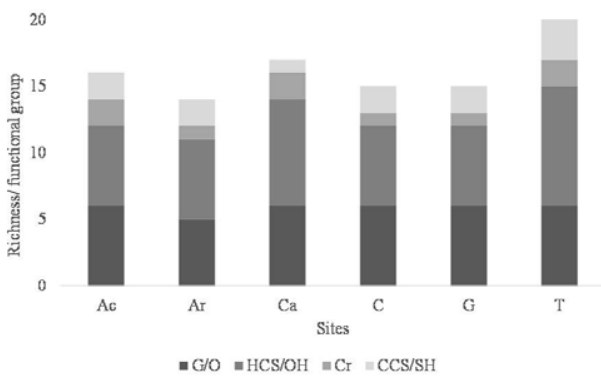
Fig 2. Richness of ants per functional group. Ac – Aciprestes; Ar – Arnozelo; Ca – Carvalhas; C – Cidrô; G – Granja; T – all sites combined; G/O - generalists and/ or opportunistic; HCS/OH - hot climate specialists and/or open habitats; Cr - cryptics; CCS/SH - cold climate specialists and/or shade